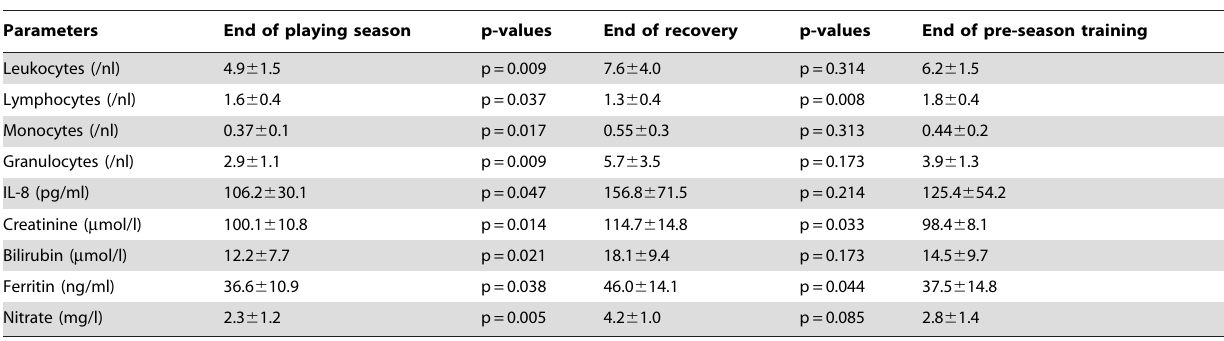
Table 3. Immunological and biochemical